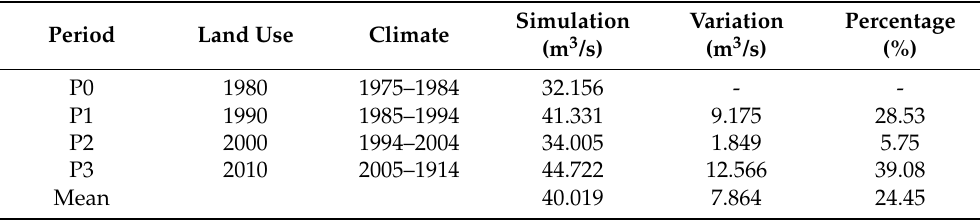
Table 5. Actual simulation surface runoff change in three periods.